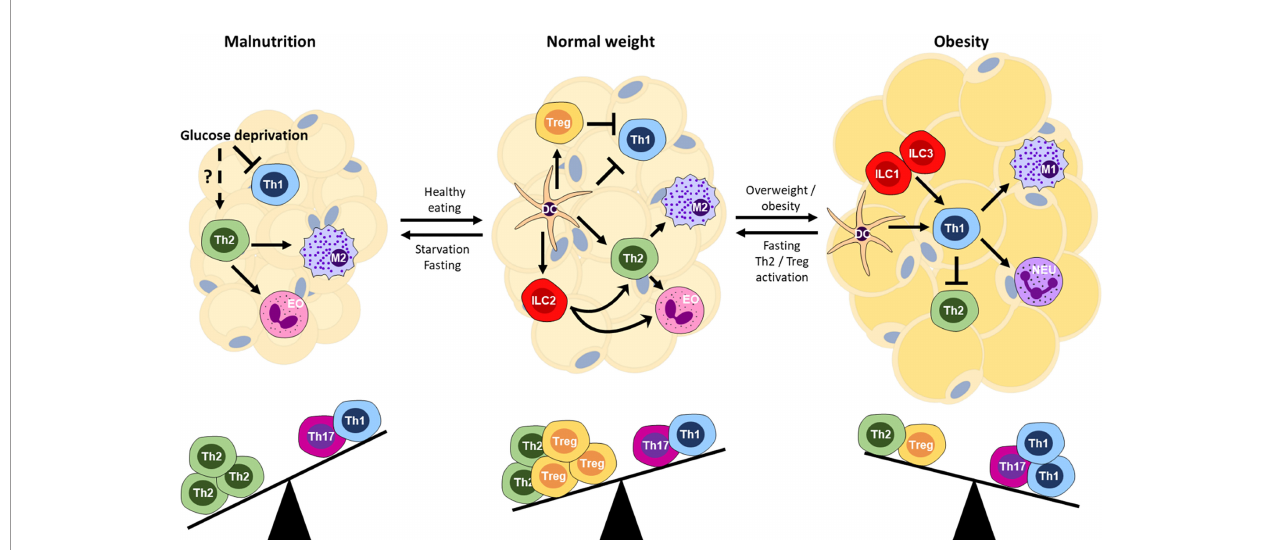
FIGURE 2 | Immune balance and the nutritional state of the host organism. Schematic of cellular interactions within adipose tissue that affect T cell subsets and downstream effector mechanisms. Th, T helper; Treg, regulatory T cells; DC, dendritic cell; M1, M1/classically activated macrophages; M2, M2/alternatively activated macrophages; EO, eosinophil; NEU, neutrophil; ILC1/2/3, innate lymphoid cell type 1/2/3.